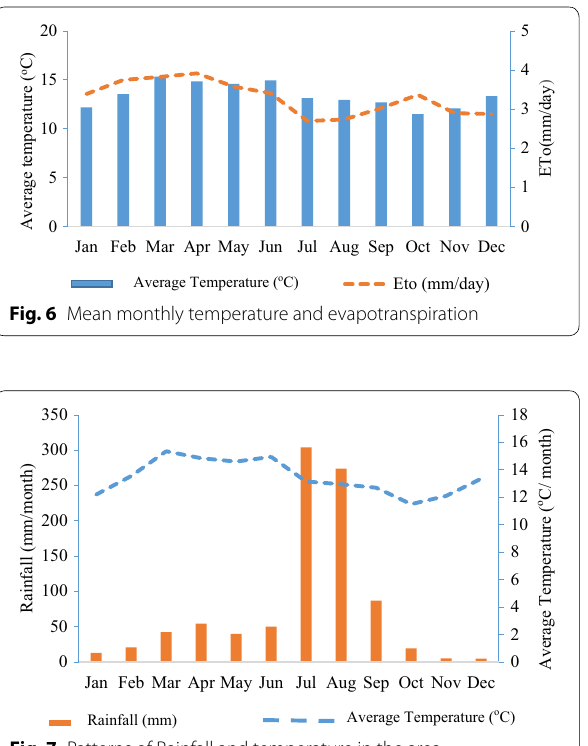
Fig. 7 Patterns of Rainfall and temperature in the